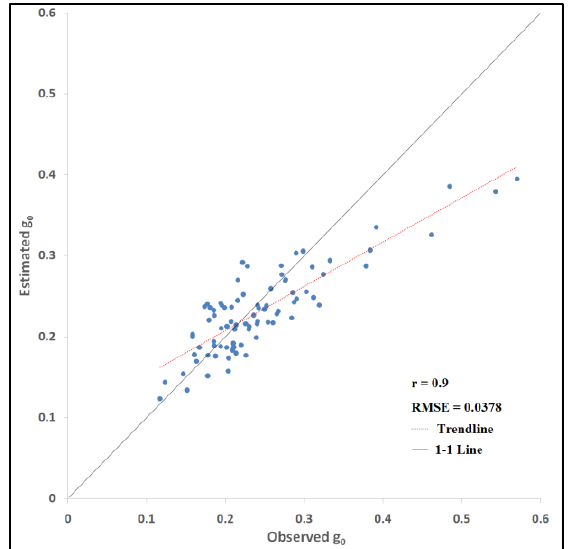
Figure 3. Scatterplot of estimated and observed g 0